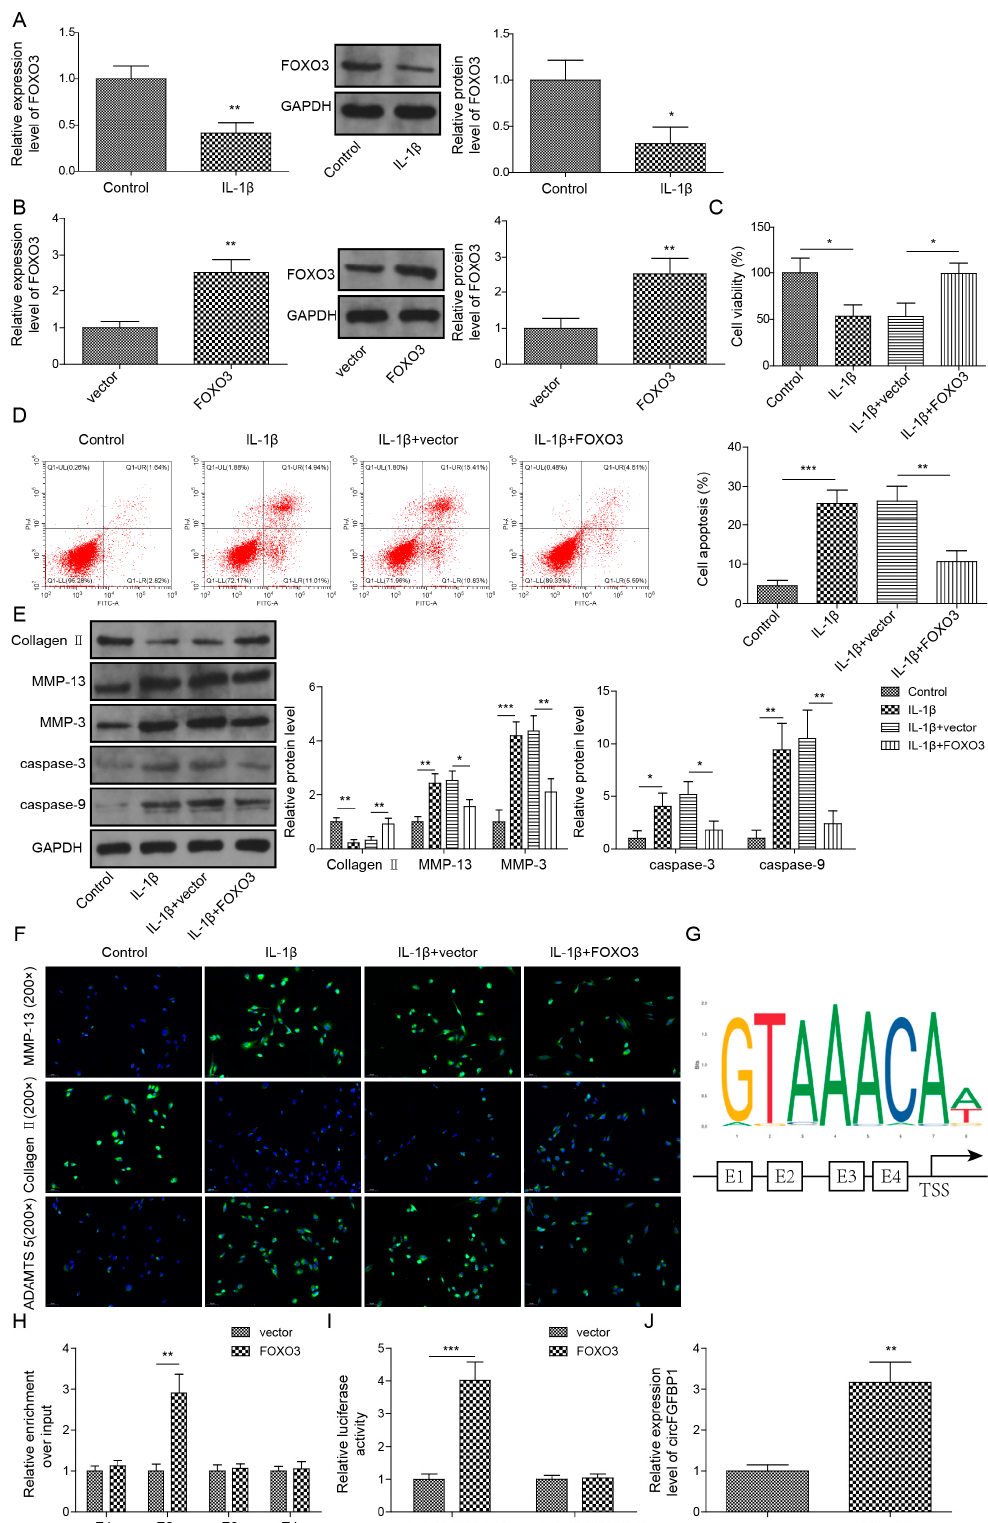
Figure 2. FOXO3 exerts its protection role in NP cell apoptosis and ECM degradation via activating circFGFBP1 transcription by binding to its promoter region. ( A ) Expression of FOXO3 in IL-1 β